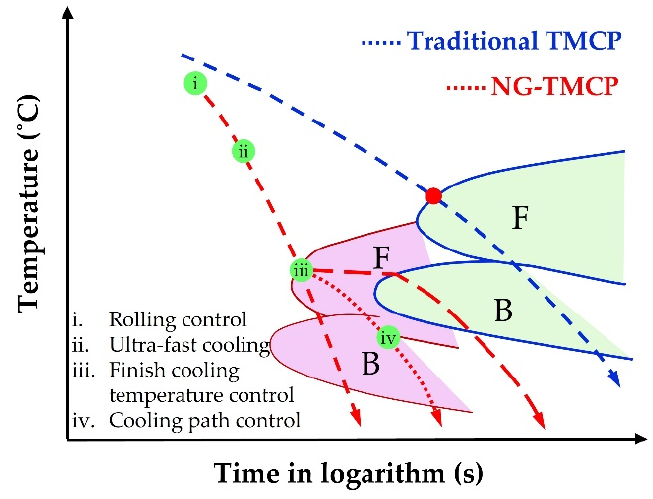
Figure 1. Schematic diagram showing the difference between NG-TMCP and traditional TMCP. F stands for ferrite, and B stands for bainite in this figure. Table 2. Thermal mechanical processing parameters of the tested Table 1. The chemical composition of the experimental steel in this study (wt.%).